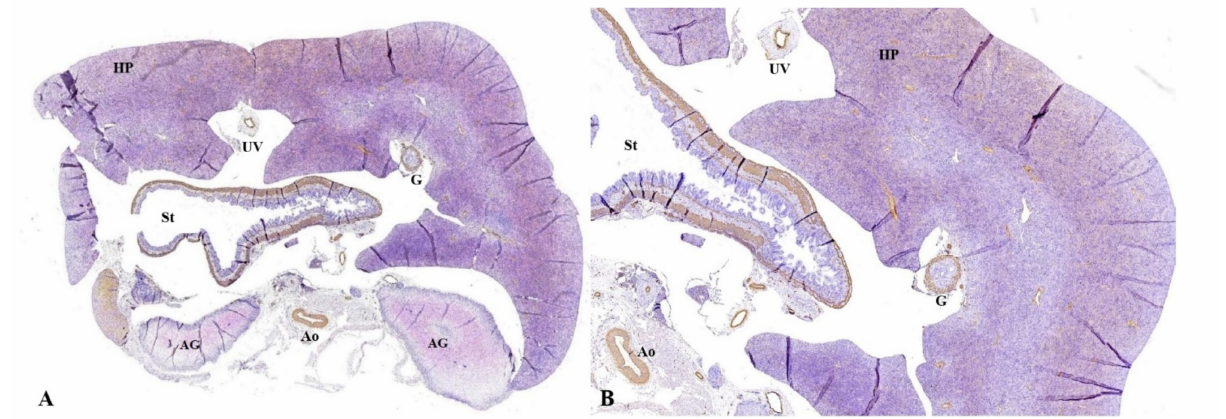
Figure 10. Transverse section at the level of the abdomen. ( A ): The liver parenchyma (HP) located anteriorly, the disorganized hepatocyte cords, the muscular tunics of the blood vessels immunolabeled with brown in both the liver parenchyma and the great hepatic vessels, the muscular and the middle tunic of the stomach (St), muscular tunic of the aorta (Ao); ( B ): the hepatic parenchyma, disorganized hepatocyte cords, muscle tunics of the blood vessels immunolabeled with brown in both the hepatic parenchyma (HP) and the great hepatic vessels are observed. Moreover, the muscular and the middle tunic of the stomach (St), muscular tunic of the aorta (Ao) are identified.